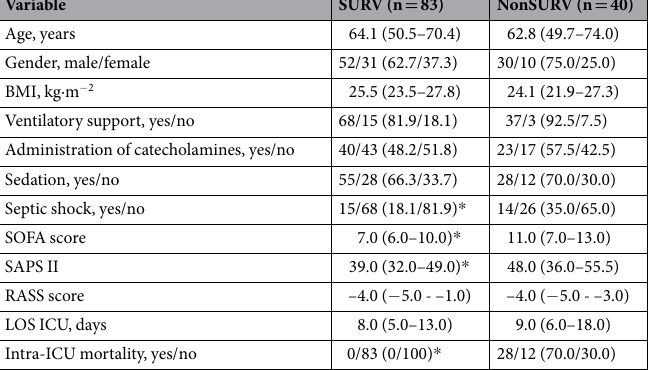
Table 1. Population characteristics. ICU = intensive care unit; SURV = patient who survived; NonSURV = patient who did not survived; BMI = body mass index; SOFA = sepsi-related organ failure assessment; SAPS II = simplified acute physiology score; RASS = Richmond agitation-sedation scale; LOS = length of stay. Categorical variables are presented as count (percentage). Continuous variables are presented as median (first – third quartiles). The symbol * indicates a significant difference with p < 0.05 using χ 2 for categorical variables and Mann-Whitney rank sum test for continuous